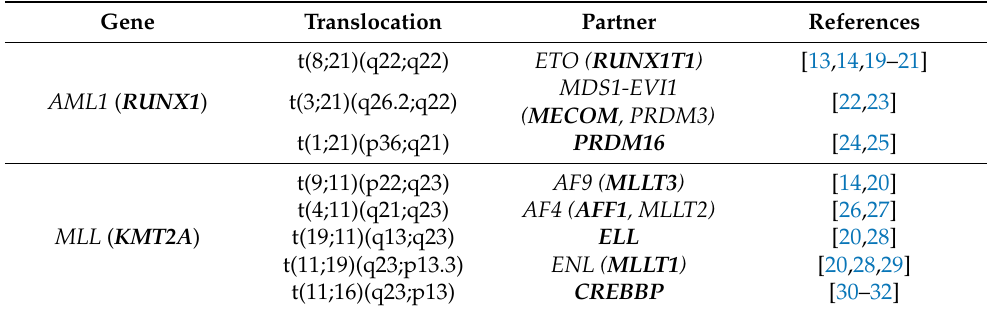
Table 1. Recurrent translocations in TI-related AML. The HUGO Gene Nomenclature Committee’s gene names are highlighted in bold.